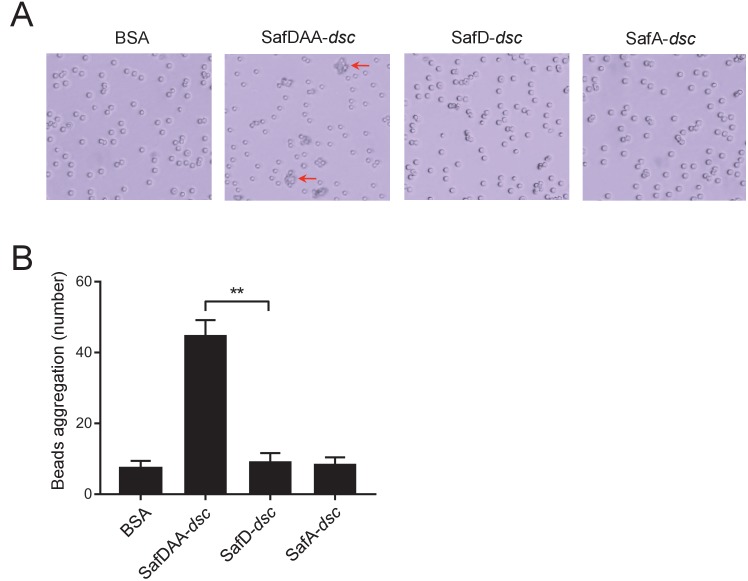
Visualization of the SafDAA-SafDAA self-association using the latex beads assay.(A) The aggregates driven by SafDAA-dsc are highlighted with arrows in the right panel. The beads coated with recombinant SafD-dsc alone, SafA-dsc alone, and BSA remained much isolated. (B) Statistics analysis of beads aggregation. Beads aggregation was qauntified by the observation of bead clusters, of which the number of beads (n) was ≥3. Values are means ±S.E. from three independent experiments, in which 100 beads were choosen for statistics analysis. **p<0.01.10.7554/eLife.28619.014Figure 5—figure supplement 1—source data 1.Source data for Figure 5
Figure 5 – figure supplementar 1B.Beads aggregation was qauntified by the observation of bead clusters, of which the number of beads (n) was ≥3. Values are means ±S.E. from three independent experiments.